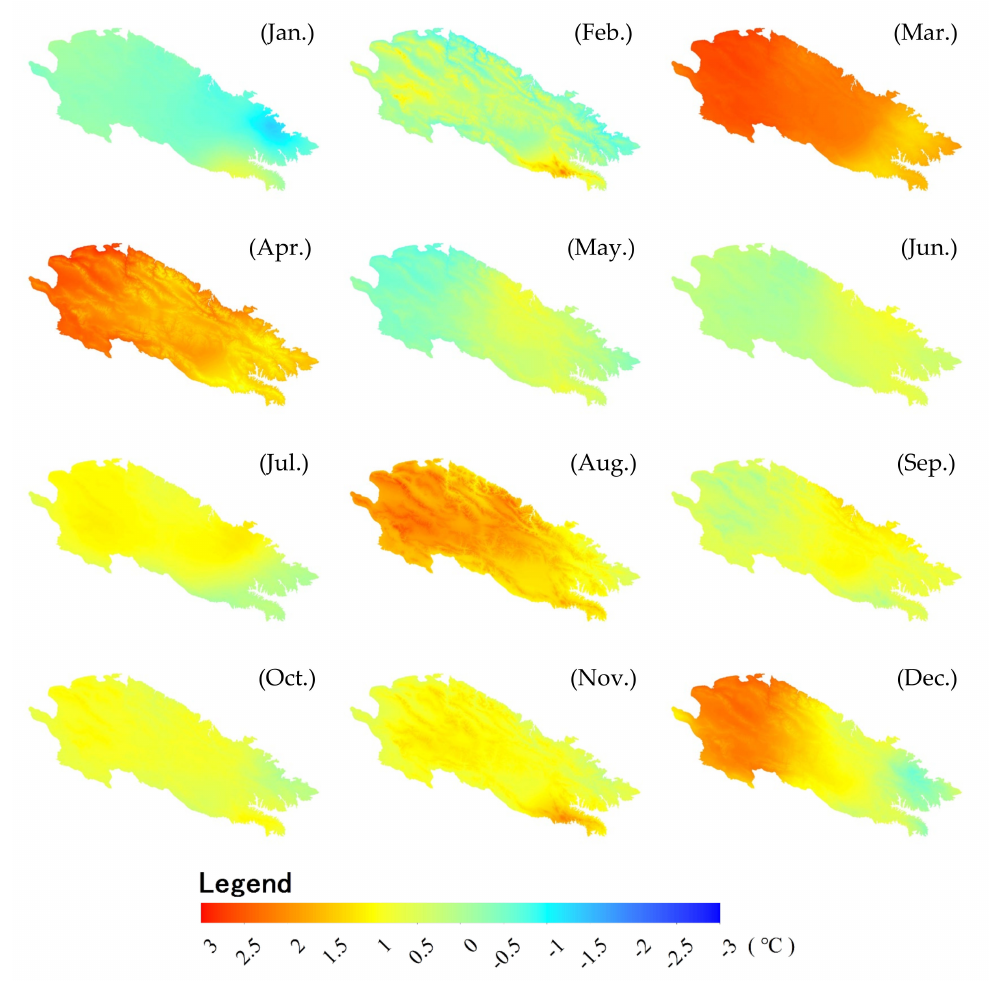
Figure 6. Difference in monthly average temperature for 20 years by linear regression from 2000 to 2019 per